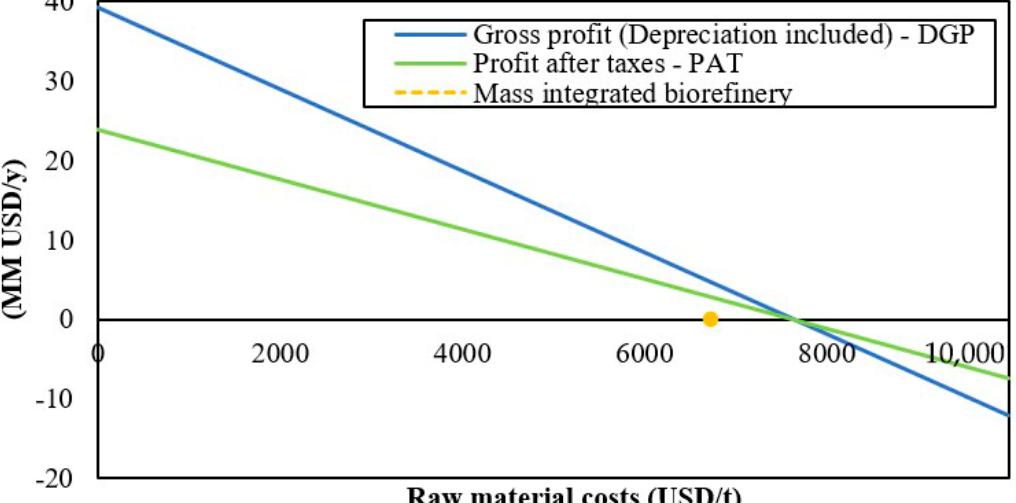
Figure 5. The e ff ect of raw material costs on